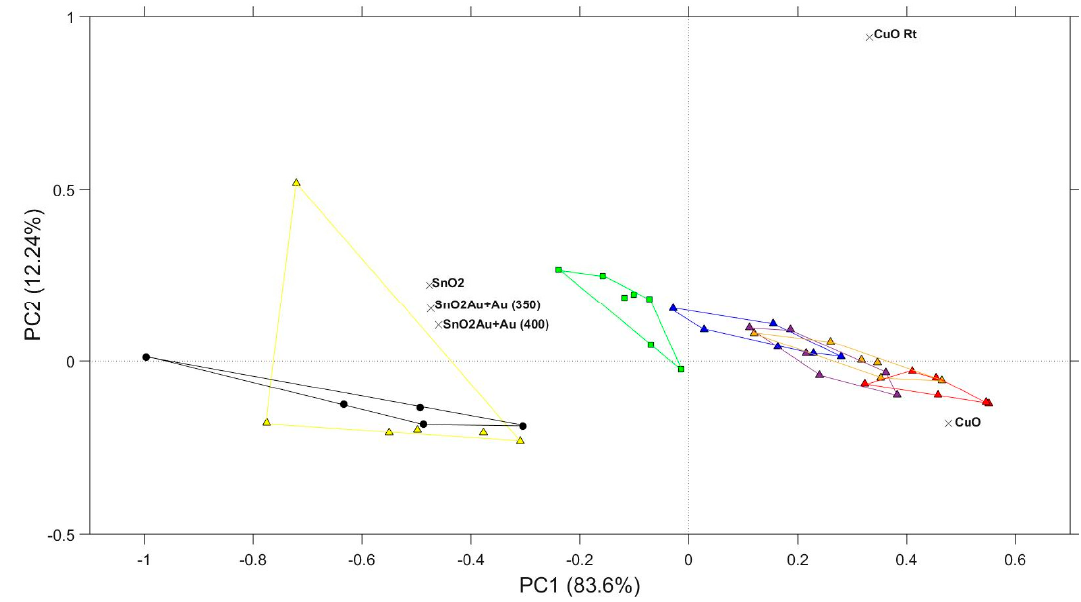
Figure 1. PCA biplot of the analyzed samples. In black water, in green wastewater, in yellow, blue, purple, orange and red wastewater with